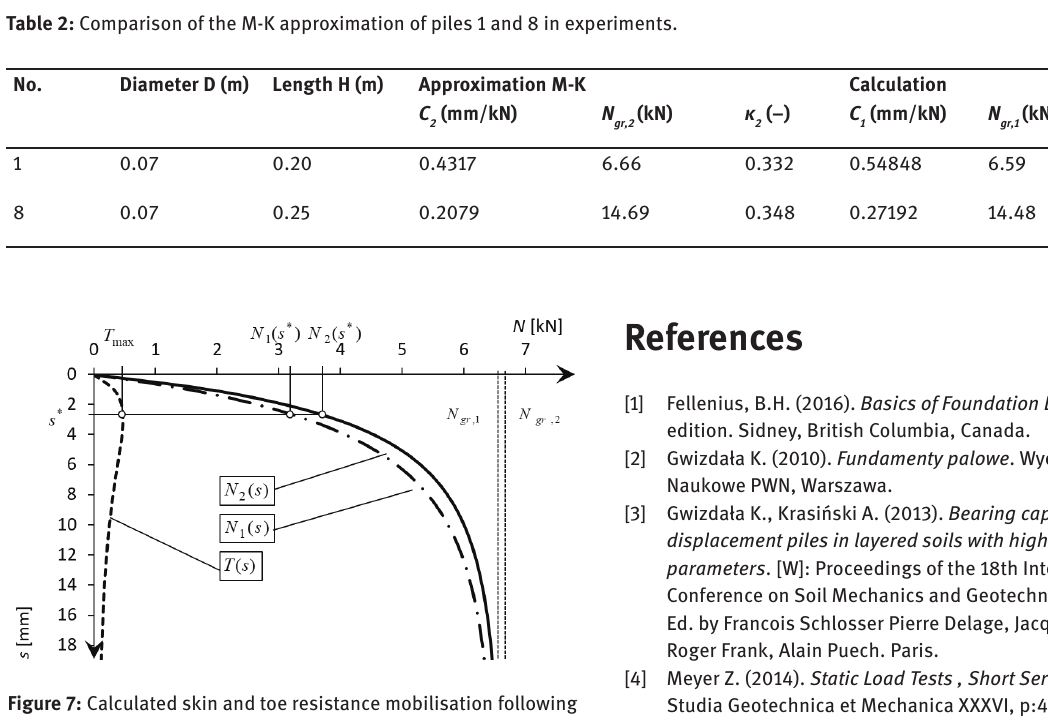
Figure 7: Calculated skin and toe resistance mobilisation following the settlement – pile 1.